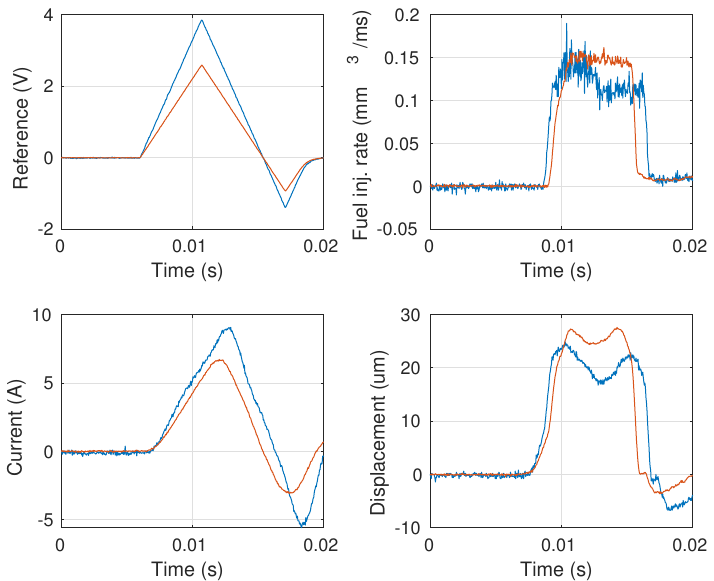
Figure 10. Comparison of measured signals with triangular reference and different amplitudes, with t inj = 10 ms and P inj = 50